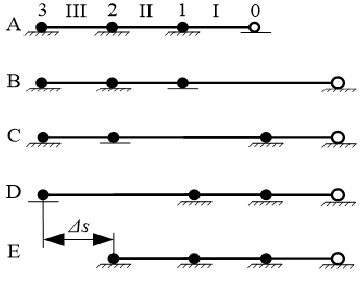
Figure 4. Rectilinear gait on a line.